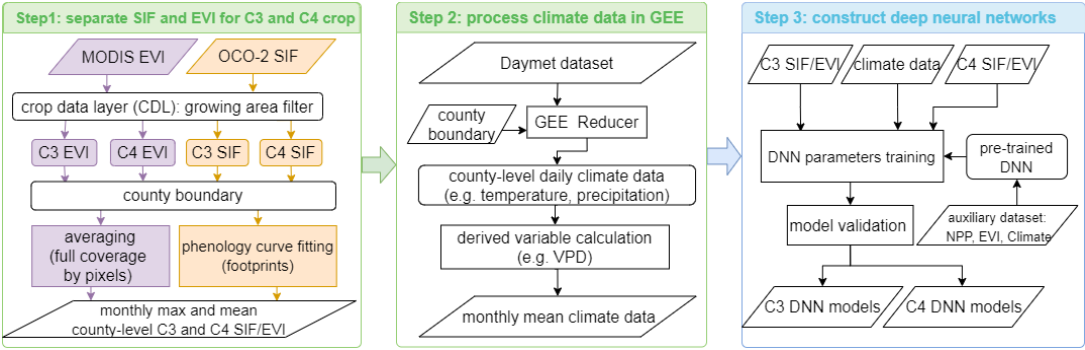
Figure 1. Flow chart of the approach used in this work.